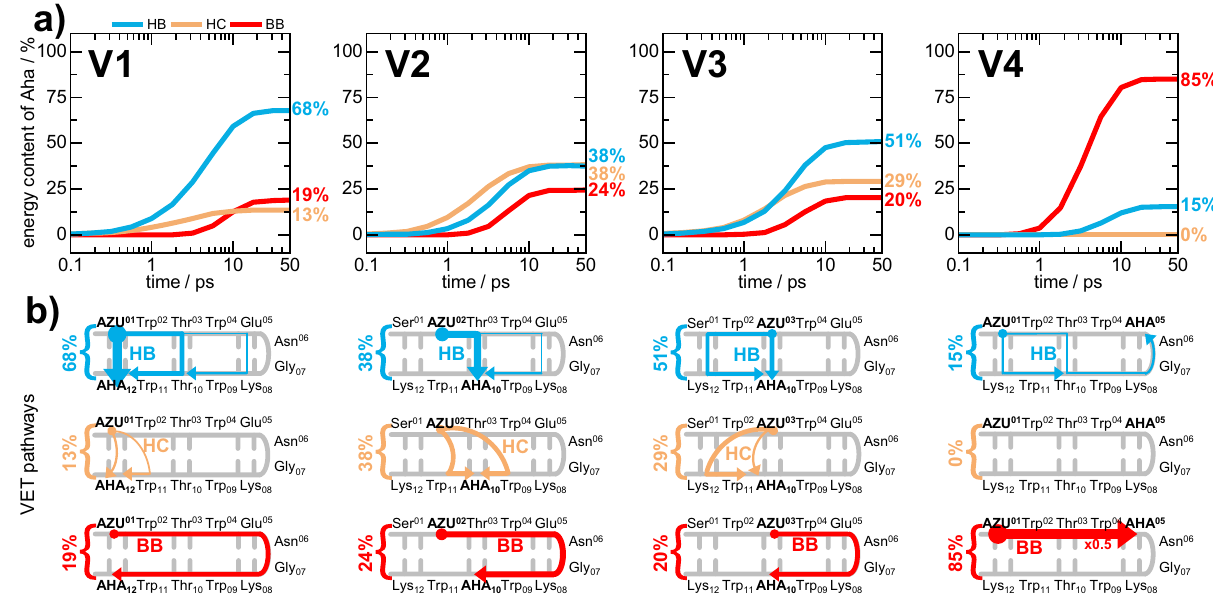
Fig. 3 Calculated VET pathways from the heater Azu to the sensor Aha in our TrpZip2 variants, obtained from Markov chain Monte Carlo simulations. a Time-dependent contributions to the energy arriving at Aha on pathways including interstrand H-bonds (HB, blue), heater contacts (HC, orange) and solely backbone (BB, red). Numbers indicate the energy contribution of the corresponding class of pathway in percent at 50 ps. b Scheme of spatially disentangled VET pathways according to Monte Carlo calculations. Color coding as in the top panel. Arrow thickness scales with the contribution of the corresponding pathway. The VET pair is highlighted with bold capitalized letters. For a better comparability the numbers from the top panel indicating the energy contribution of the corresponding class of pathway are shown. Source data underlying Fig. 3a are provided as a Source Data fi